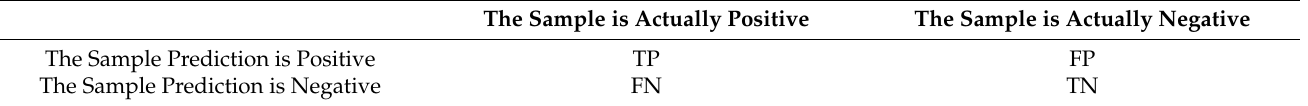
Table 4. Confusion